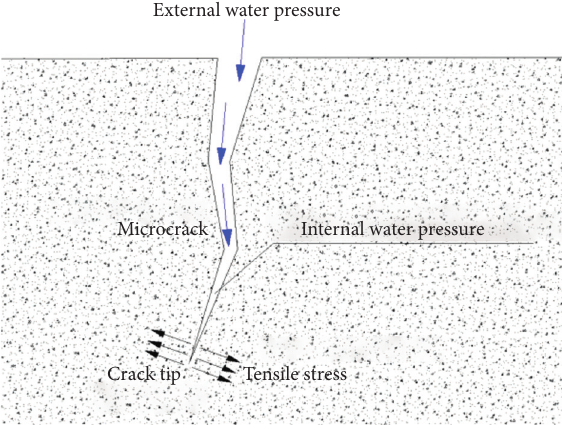
Figure 19: Microcrack propagation as water pressure increases.